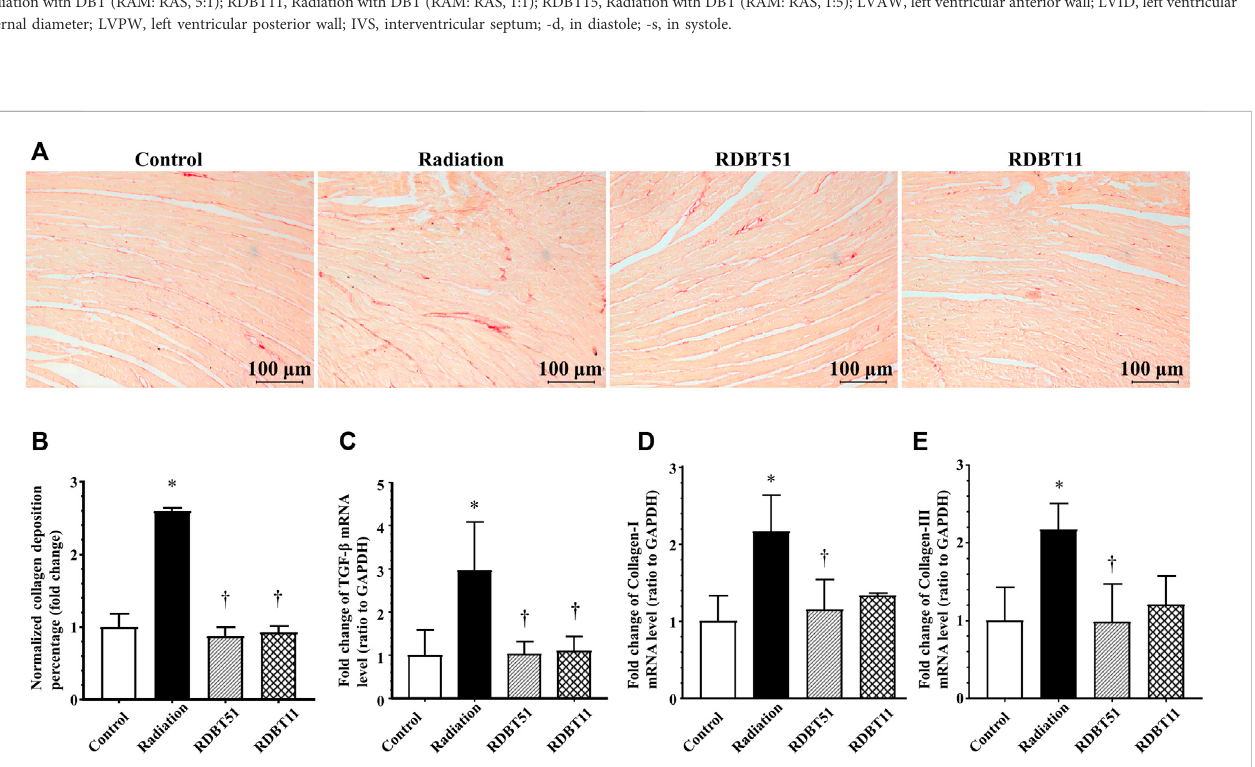
FIGURE 4 The DBT alleviates radiation-induced cardiac fi brosis. (A) Representative microphotographs of Sirius red staining obtained at 8 weeks after radiation; (B) Quantitative results of collagen deposition percentage; (C) , (D) , and (E) The myocardial mRNA levels of TGF- β , Collagen-I and Collagen-III relative to